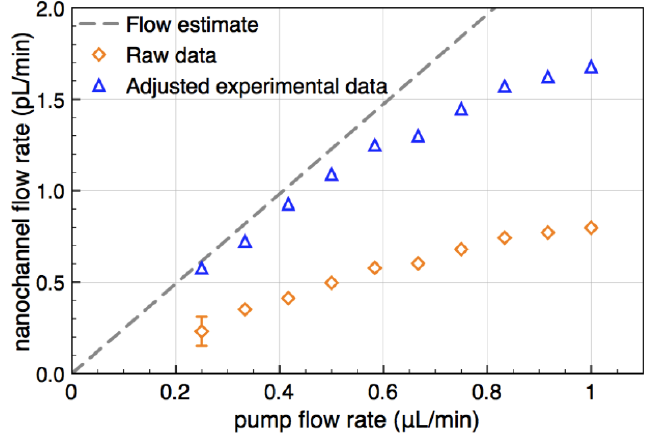
Figure 4. Nanofluidic flow rates as a function of syringe flow. The adjusted experimental data points are corrected for the shift of the peak times as well as for dynamic adsorption. The dashed line’s slope corresponds to the ratio of the micro- and nanochannels’ resistances of 1